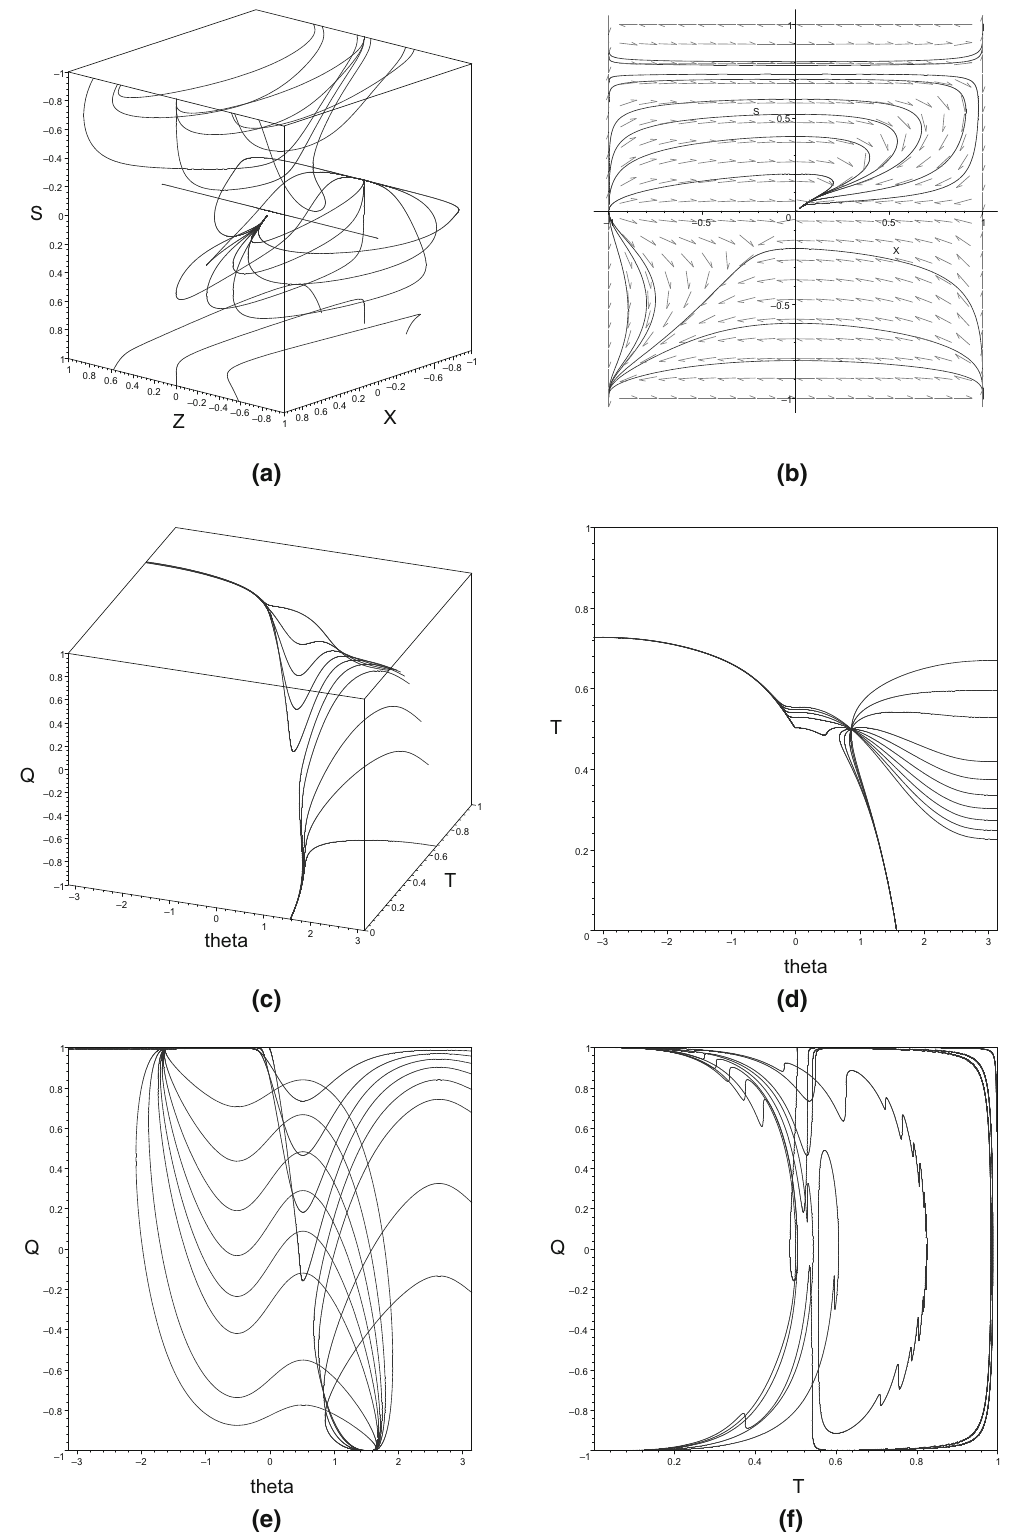
Fig. 6 a Compact phase portrait of (162), (163), (164) for the choice n = 2 ,μ = 1. b Dynamics in the invariant set Z = 0. c – f Dynamics of the system (191), (192), (193) and some 2D projections for n = 4 ,μ =